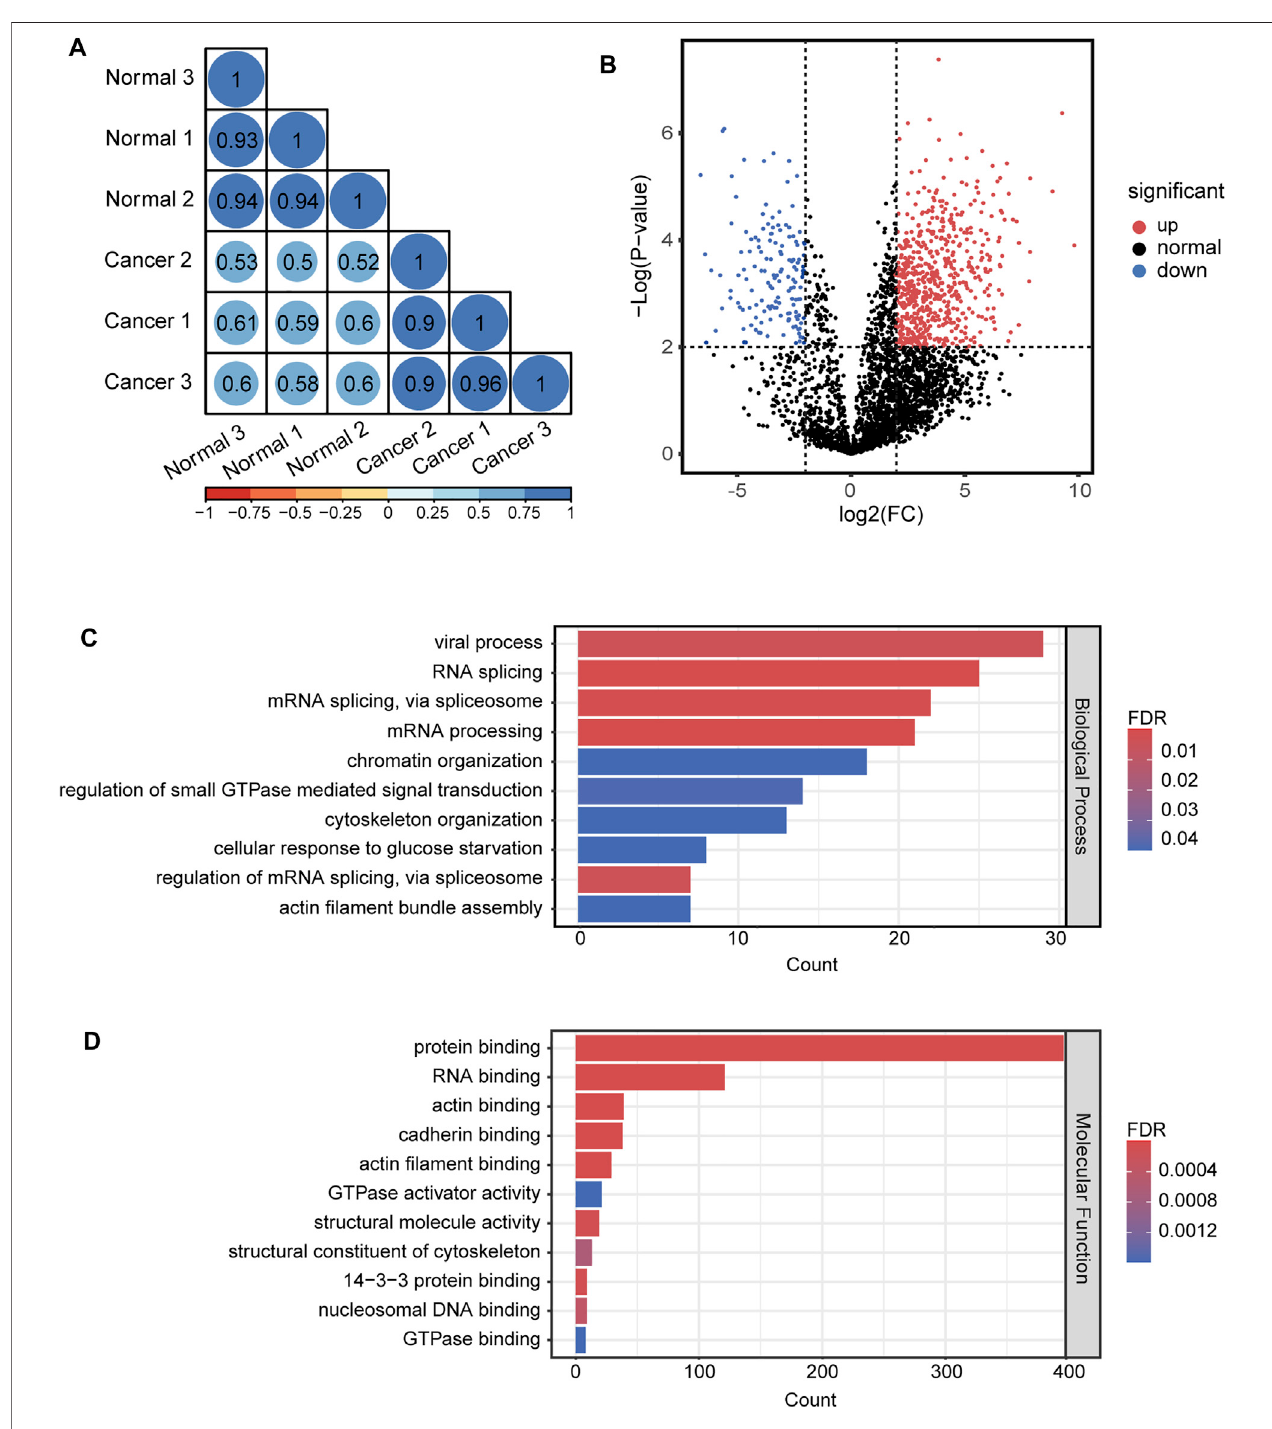
FIGURE9| QuantitativedifferentialanalysisandGOanalysisofphosphositesfromlungcancerandnormaltissue. (A) quanti fi cationcorrelationofphosphosites. (B) volcano plot of phosphosites. (C) biological process of GO analysis of the dysregulated phosphoproteins. (D) molecular function of GO analysis of the dysregulated